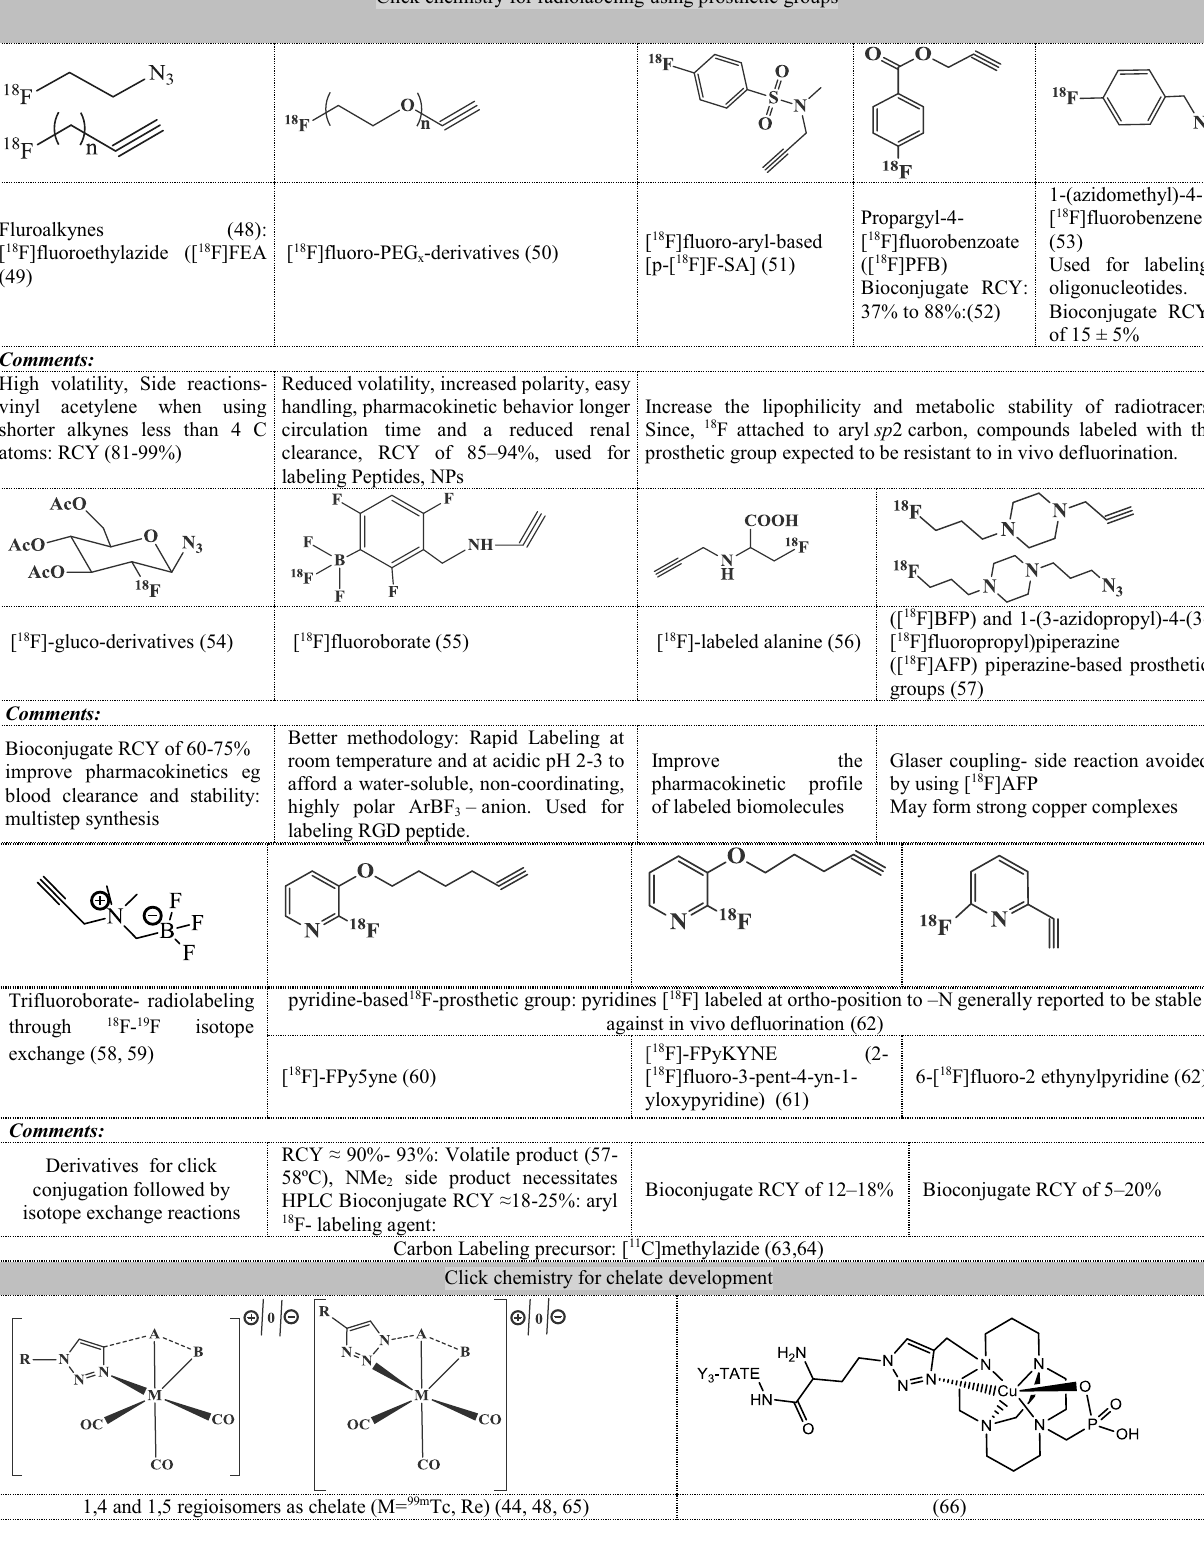
FiGURe 5 | Applications of click chemistry. Structures referenced in (41, 42,